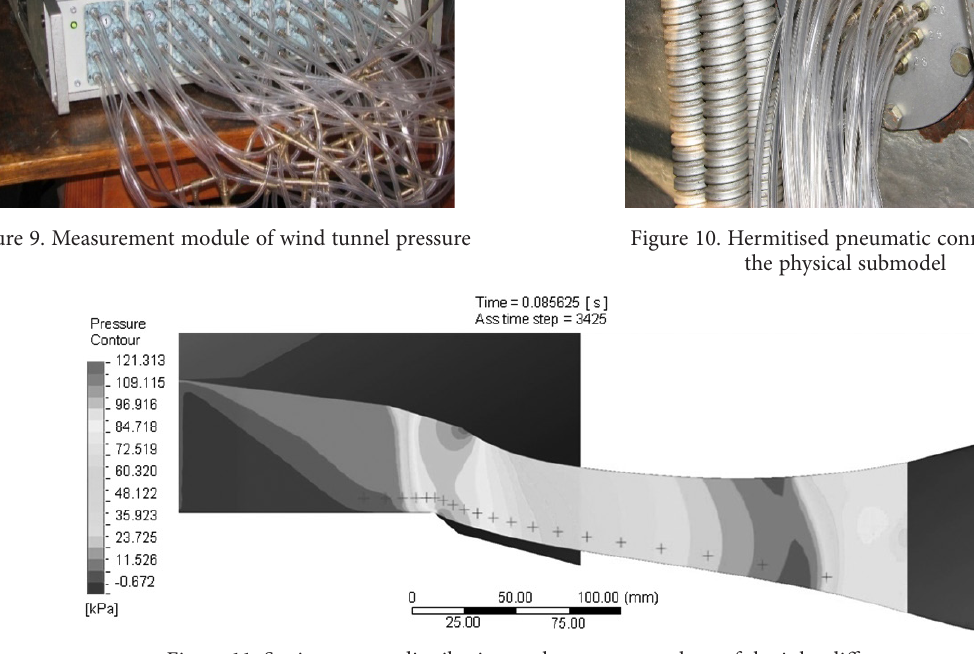
Figure 11. Static pressure distribution at the symmetry plane of the inlet diffuser